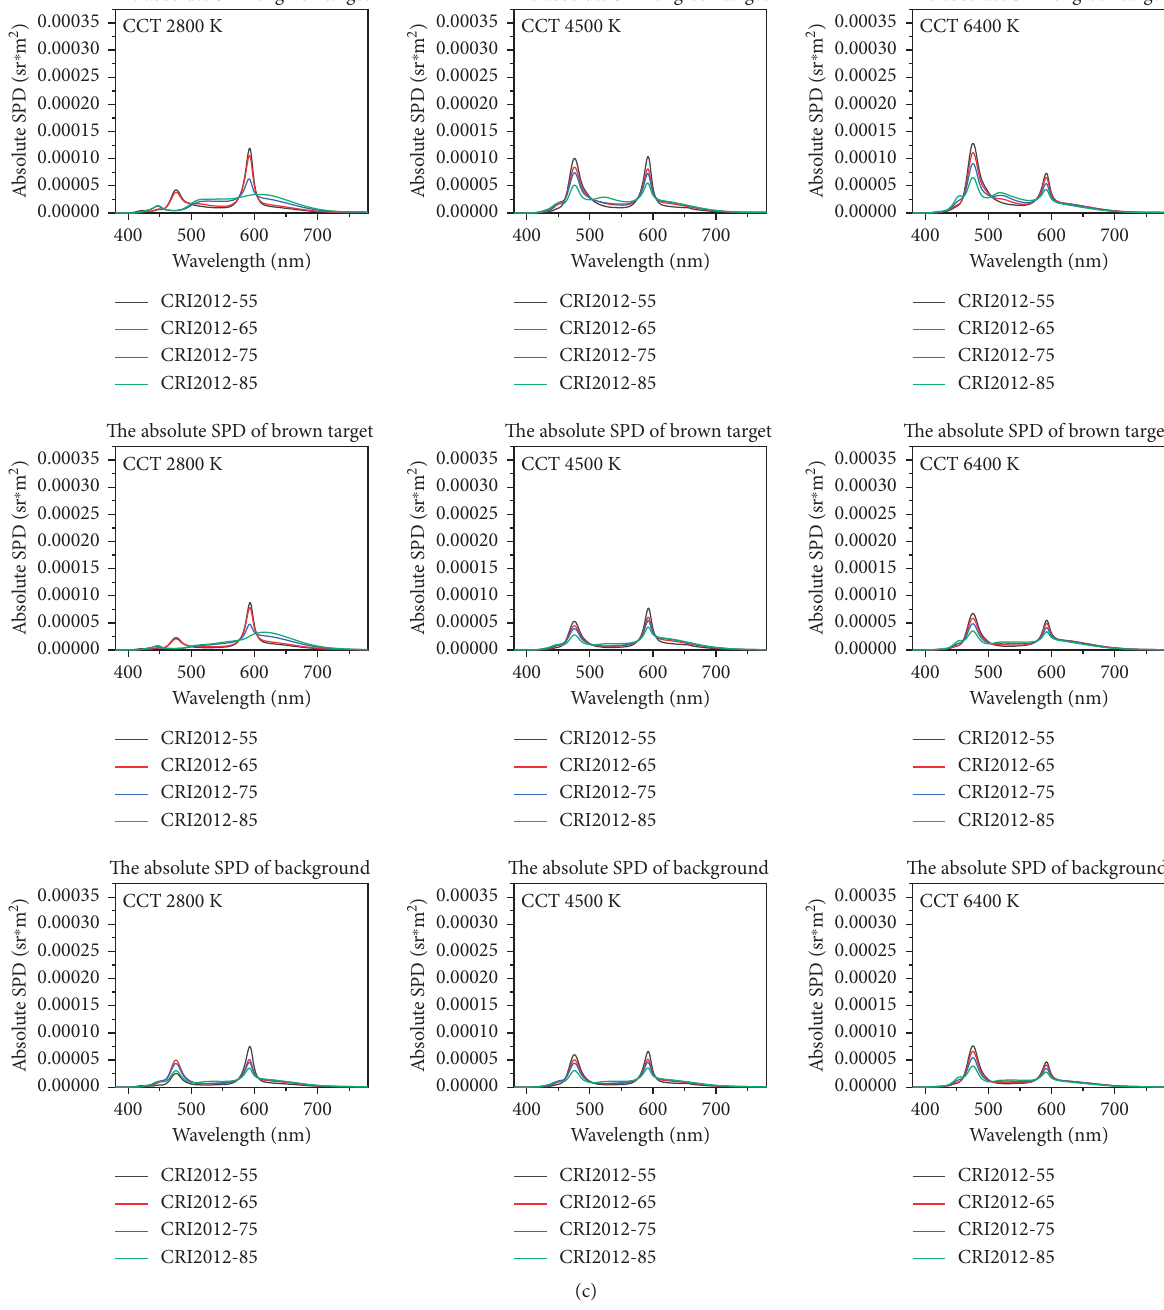
Figure 3: Absolute SPD of targets with different CRI2012s and